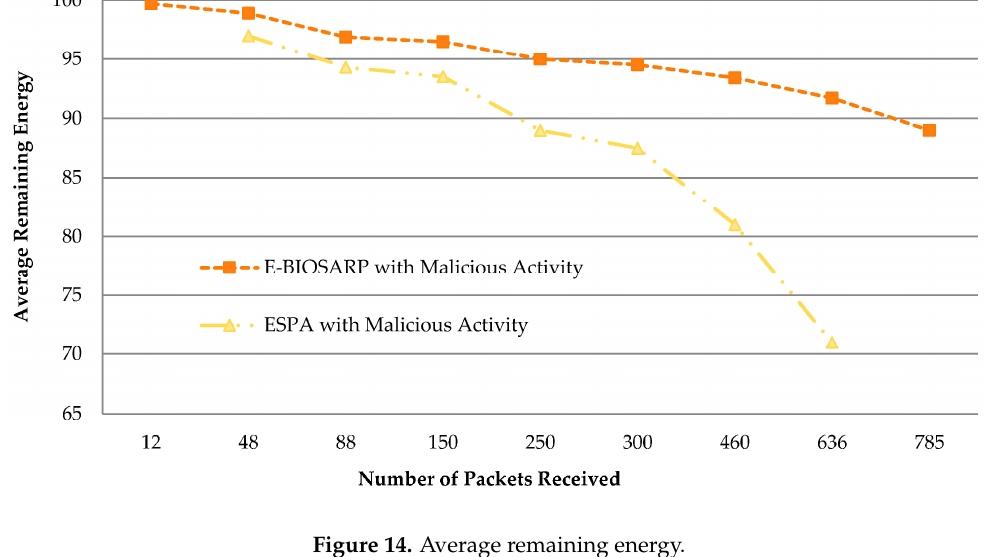
Figure 14. Average remaining energy.